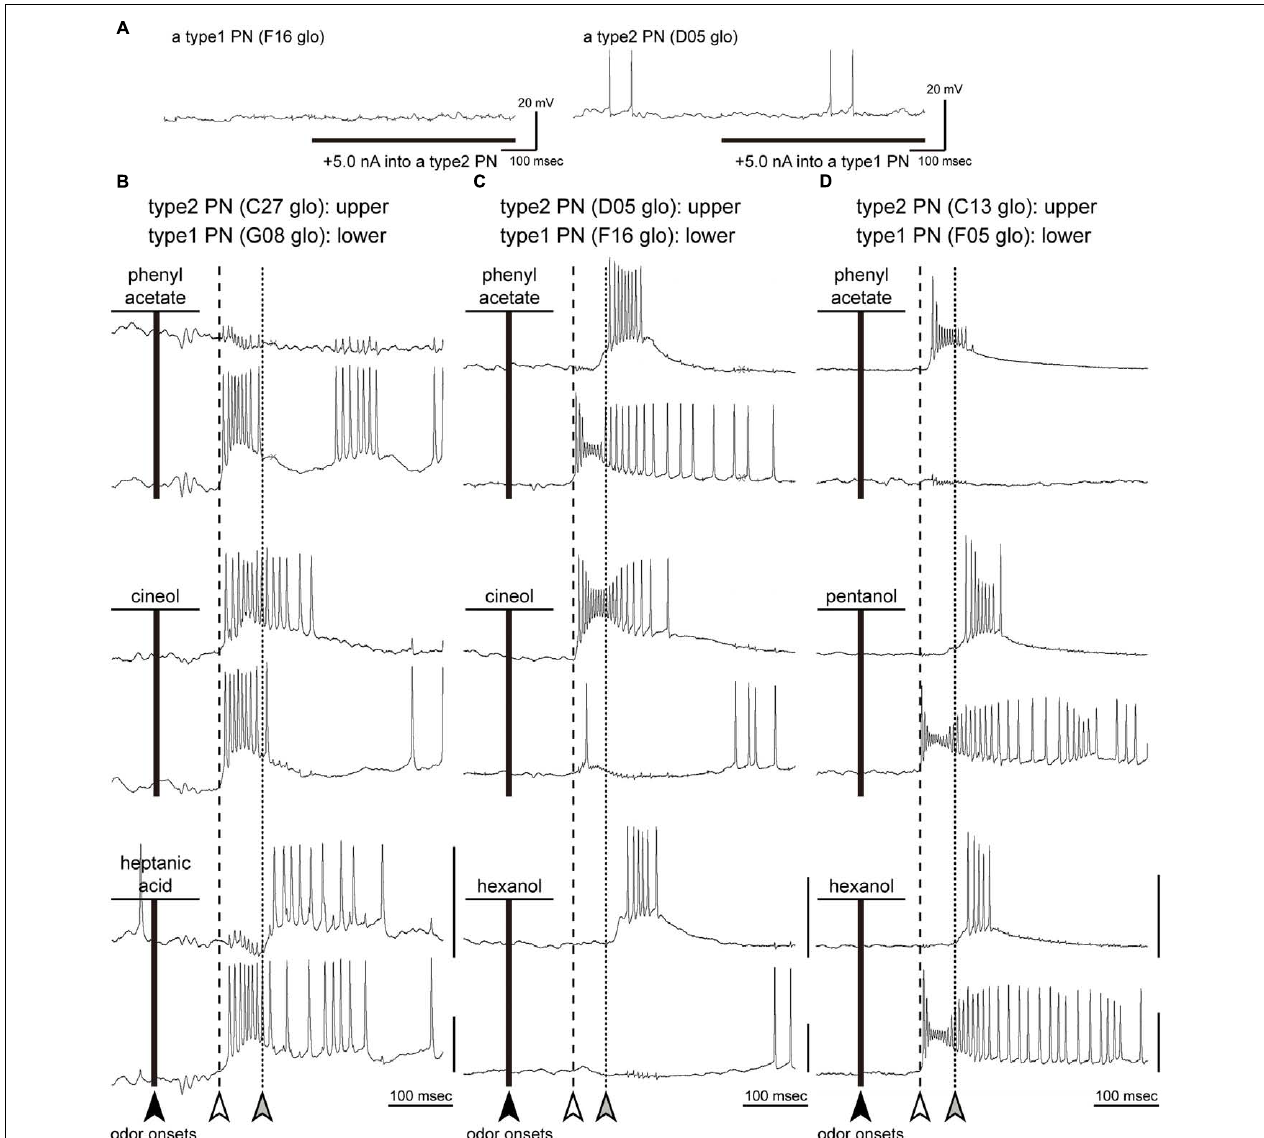
FIGURE 8 | Simultaneous intracellular recordings from a type1 PN and a type2 PN. (A) Current injection to a PN. The artificial excitation of one PN by an inward current injection (5.0 nA) did not affect the membrane potential of the other PN. (B–D) Three pairs of response traces of simultaneous recordings from a type2 PN (upper traces) and a type1 PN (lower traces). The glomeruli innervated by PNs are denoted in each panel. We selected typical combinational responses elicited by three different odorants (black lines). Olfactory responses are arrayed based on timings of odor onsets (black arrowheads). Based on type2 PN response patterns, we identified latencies of early (white arrowheads and broken lines) and late responses (gray arrowheads and dotted lines) in each simultaneous recording. In each trace, there was considerable cross-talk (1–5 mV) between the two simultaneously recorded signals. Vertical bars = 20